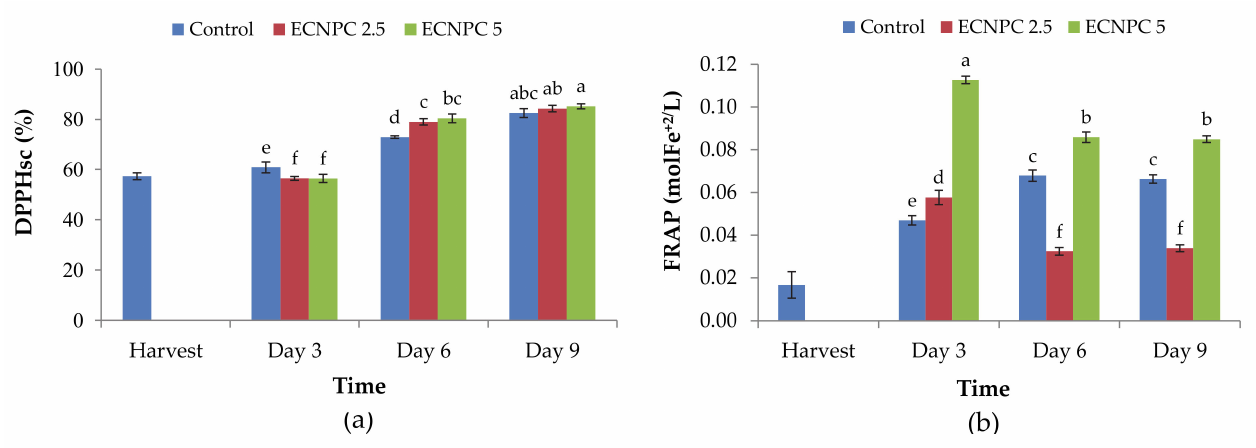
Figure 4. Effect of chitosan nano-emulsion coatings (at 0 g L − 1 , 2.5 g L − 1 , and 5 g L − 1 ) on antioxidant activity ( a ) 2,2- diphenyl-1-picrylhydrazyl-hydrate (DPPH) and ( b ) Ferric reducing antioxidant power (FRAP) of raspberries stored for 9 d (at 4 ± 1 ◦ C with 90–95% RH). Control refers to untreated raspberries. The data shown are the mean ± standard error of four replicates. Different letters indicate statistical significance ( p <